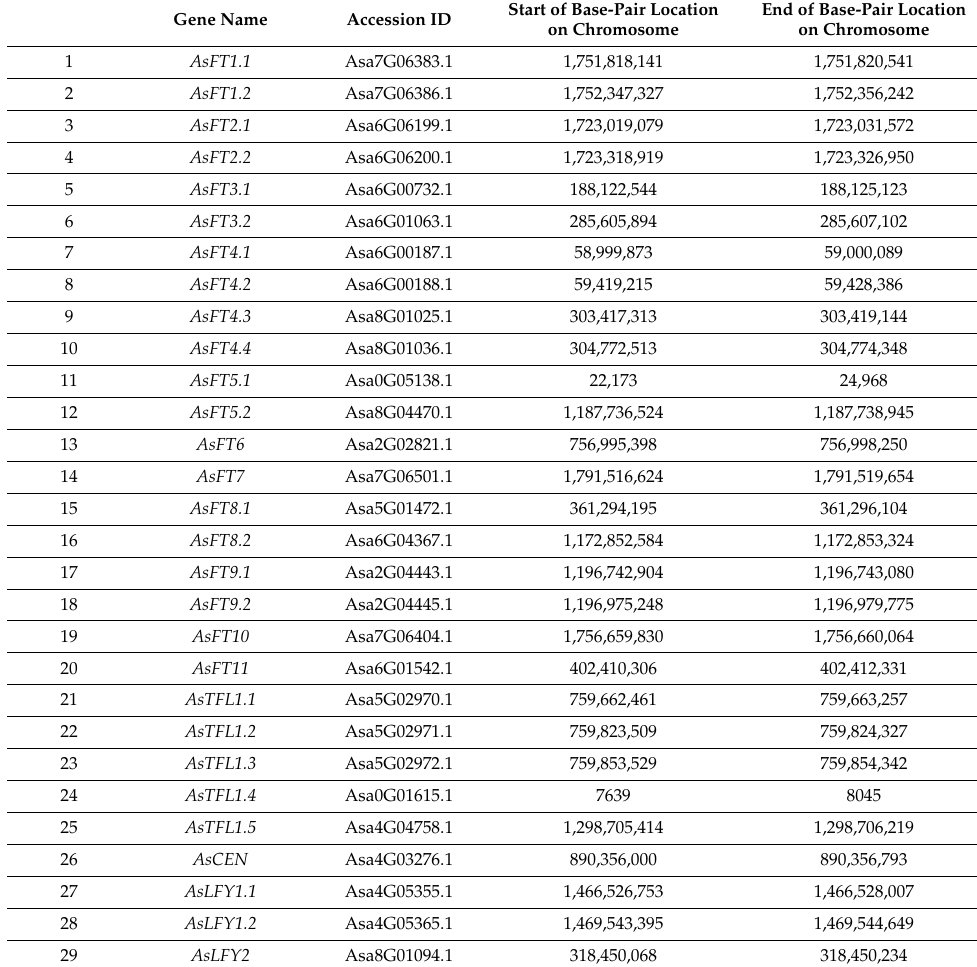
Table 1. List of flowering-related genes from the PEBP and LFY families in the garlic genome, accession IDs from Sun et al.